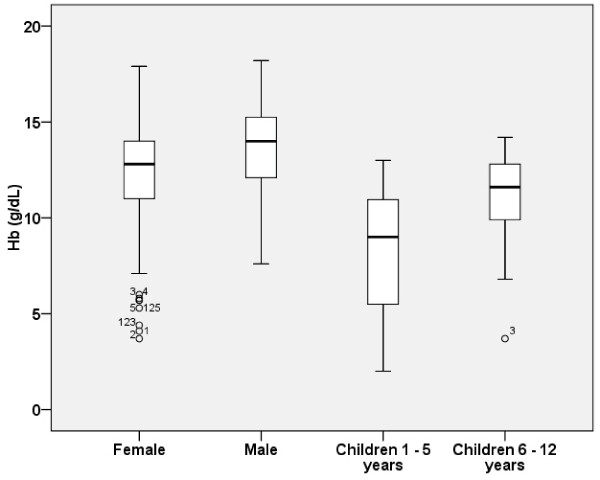
Box and whisker plots showing variation in haemoglobin (Hb) values in malaria-negative Ethiopian adults and children. n = 127 for female samples, n = 84 for male samples, n = 126 for child samples between one and five years old, n = 117 for child samples between six and 12 years old.